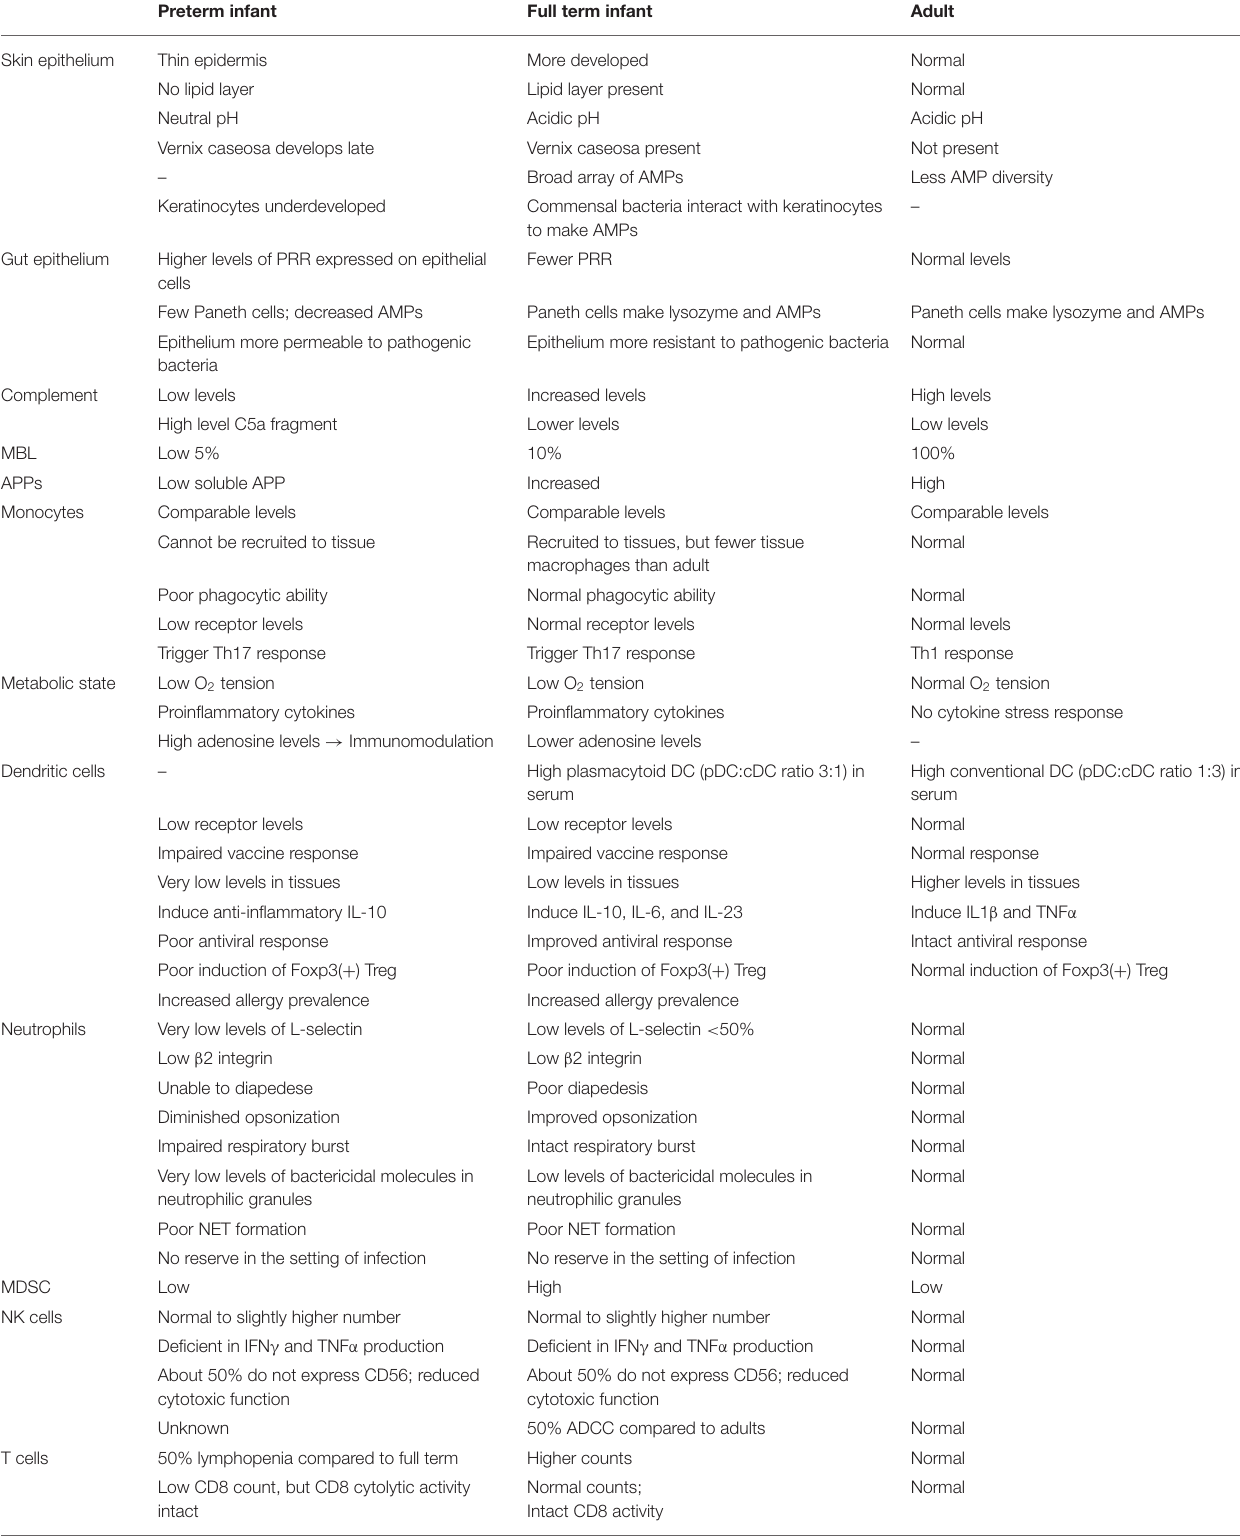
TABLE 1 | Summary of differences in development between preterm infant, term infant and adult immune components. Preterm